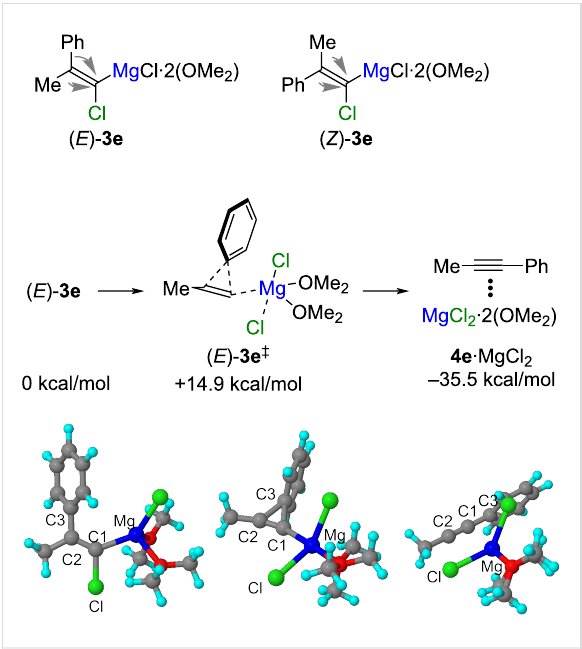
Figure 1: Optimized geometries of reactant ( E )- 3e , transition state ( E )- 3e ‡ , and product 4e ·MgCl 2 for the FBW rearrangement of magne- sium alkylidene